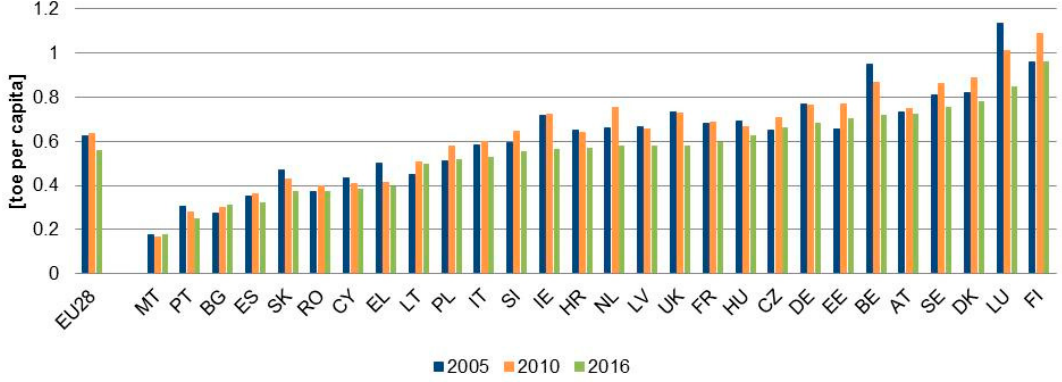
Figure 6. Final Energy Consumption (FEC) per capita in residential sector by EU-28 member state, in 2005, 2010, and 2016. Source: Eurostat.